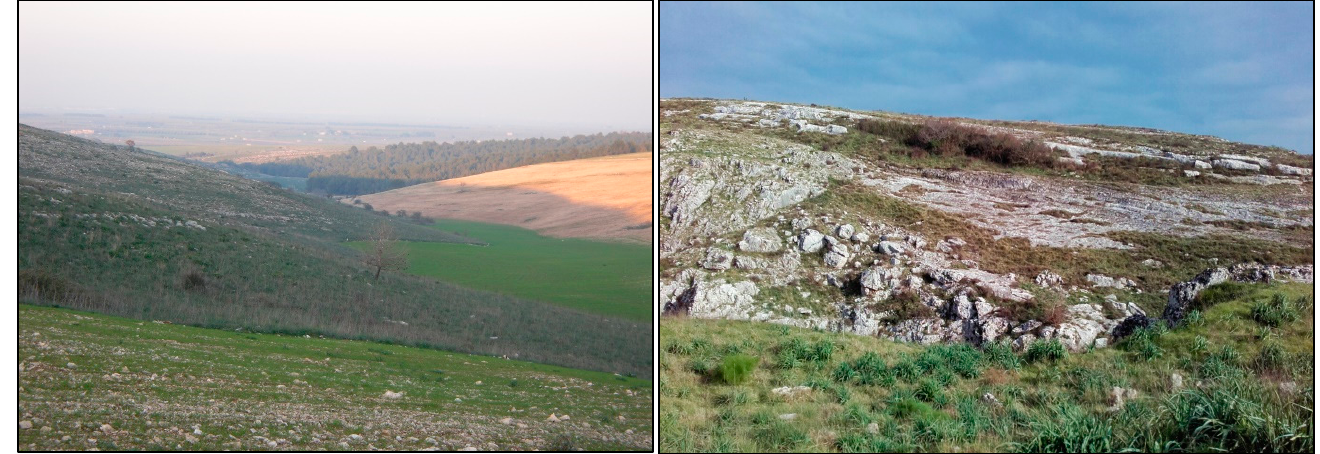
Figure 2 . “ Murgia Alta”